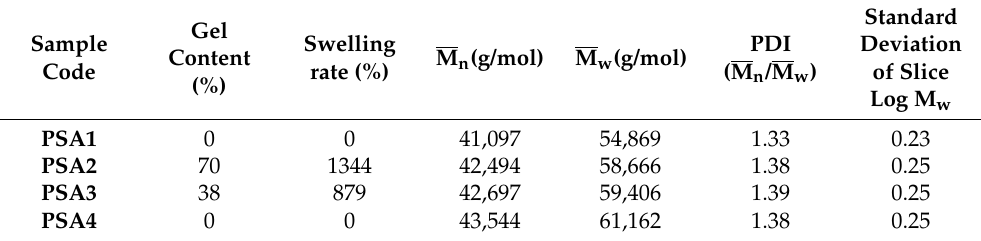
Table 2. The gel content, swelling rate, number-average molecular weight (M n ) weight-average molecular weight (M w ) and PDI of the sol of the four